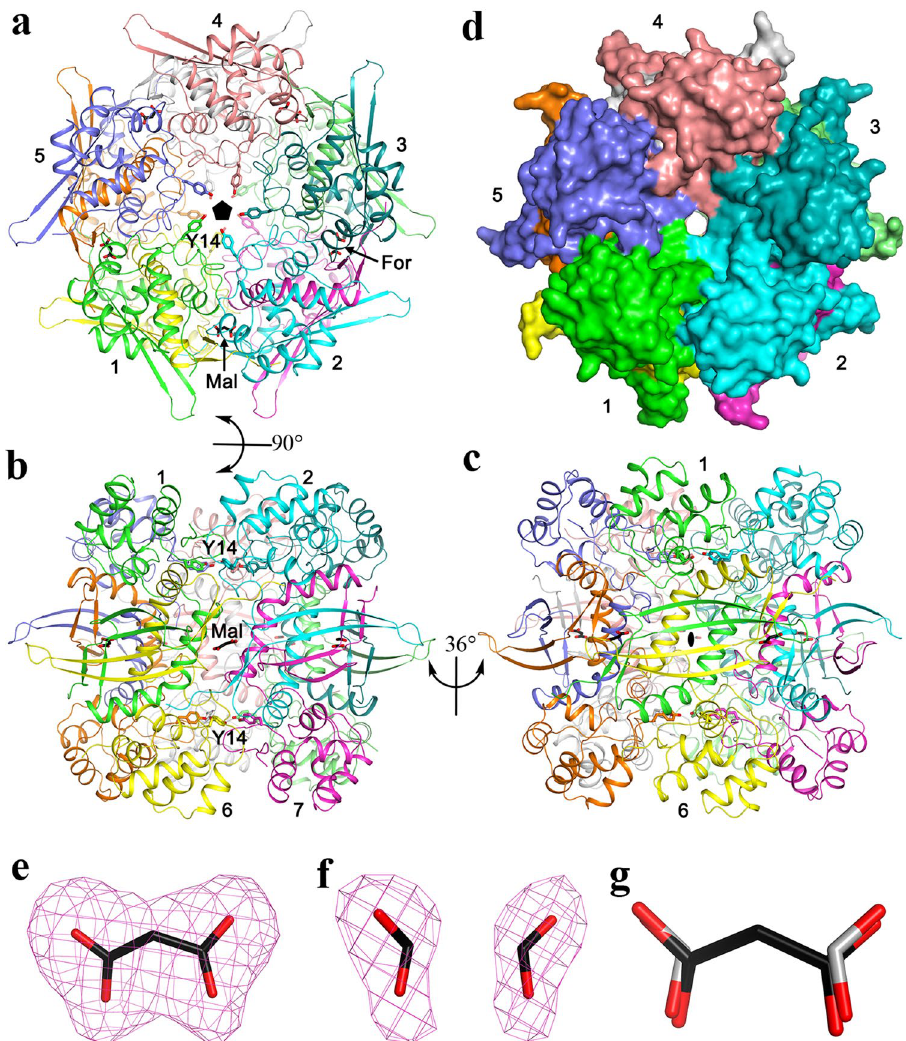
Figure 2. Crystal structure of the fungal cyanase decamer. ( a ) Overall structure of the Tl-Cyn decamer (top view). Each monomer is depicted in a different color. The side chains of Y14 are shown as sticks, pointing towards the center of the structure. The malonate (labeled Mal) and formate (labeled For) molecules bound to the active sites of the decamer are shown as sticks. The five-fold symmetry axis of the decamer is indicated with the black pentagon. ( b ) Overall structure of the Tl-Cyn decamer viewed after a 90° rotation around the horizontal axis. ( c ) Overall structure of the Tl-Cyn viewed after a 36° rotation around the vertical axis from panel ( b ). A two-fold axis of the decamer is indicated with the black oval. ( d ) Molecular surface of the Tl-Cyn decamer, viewed in the same orientation as in ( a ). ( e ) Omit F o − F c electron density at 2.2 Å resolution for malonate, contoured at 3 s. ( f ) Omit F o − F c electron density at 2.2 Å resolution for two formate molecules, contoured at 3σ. g, Overlay of the binding modes of malonate (black carbon atoms) and two formate molecules (gray carbon